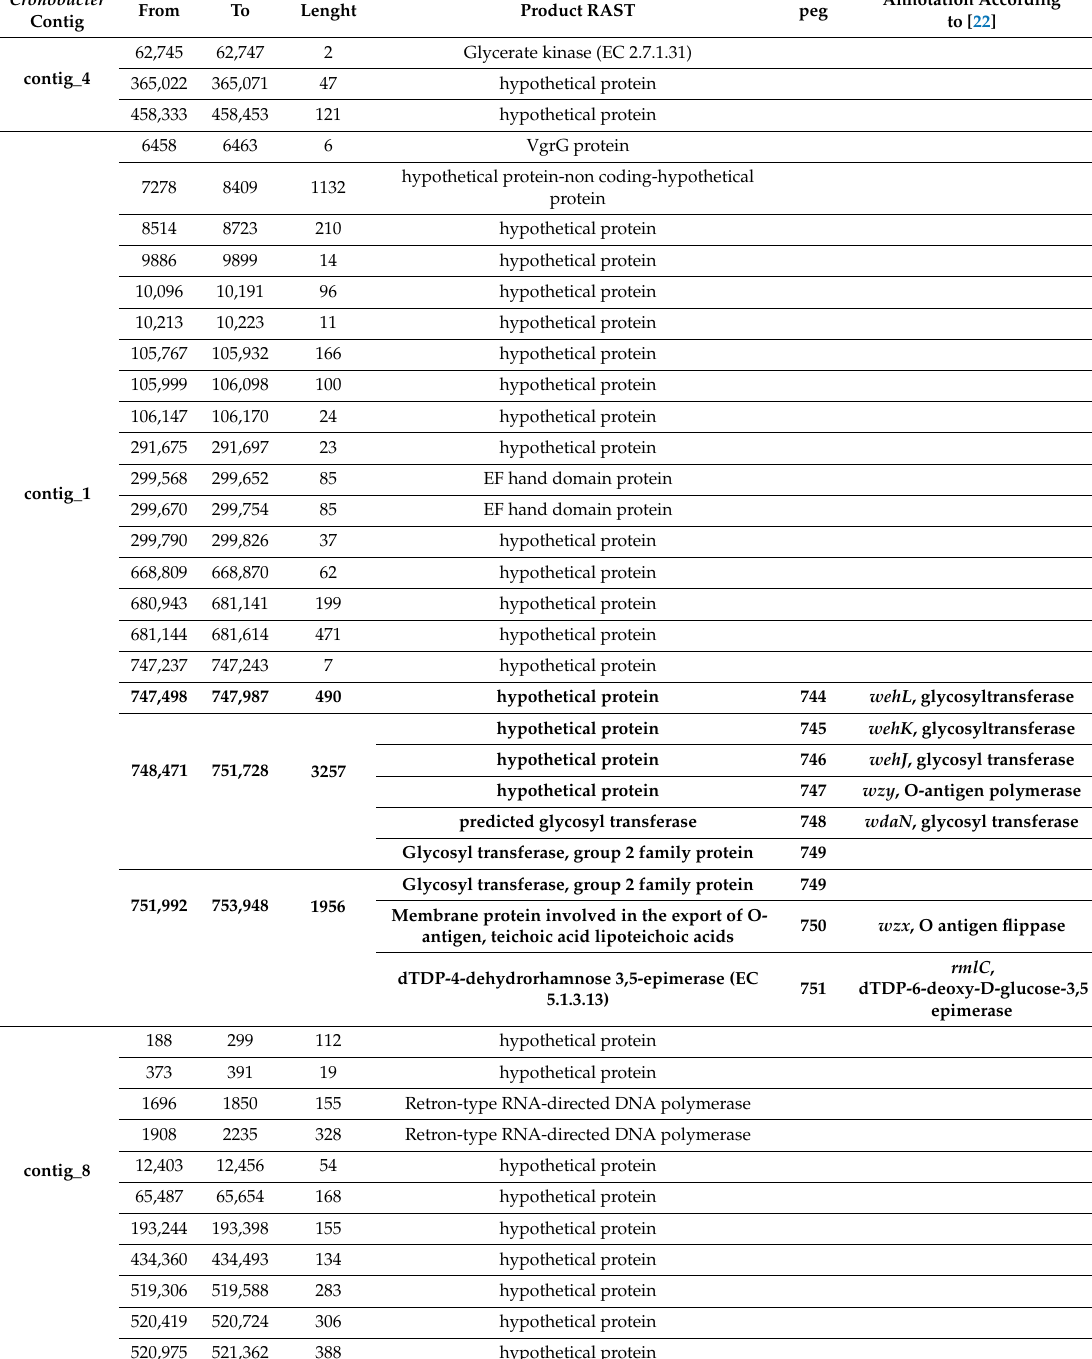
Table A4. Identification of the phage receptor in Salmonella and Cronobacter . For both, we report the position on the contig (contig, from, to, length), the corresponding gene product according to the RAST annotation (product RAST) and the protein gene product (peg); for the genes involved in the O-antigen production, we also report the gene name and product according to the references [22,23]. Reads from C. sakazakii CS1 mutant R3 mapped on CS1 wt. Coverage < 5 reads, on contigs longer than 100,000 bp. In bold the ORF coding for the O-antigen and the